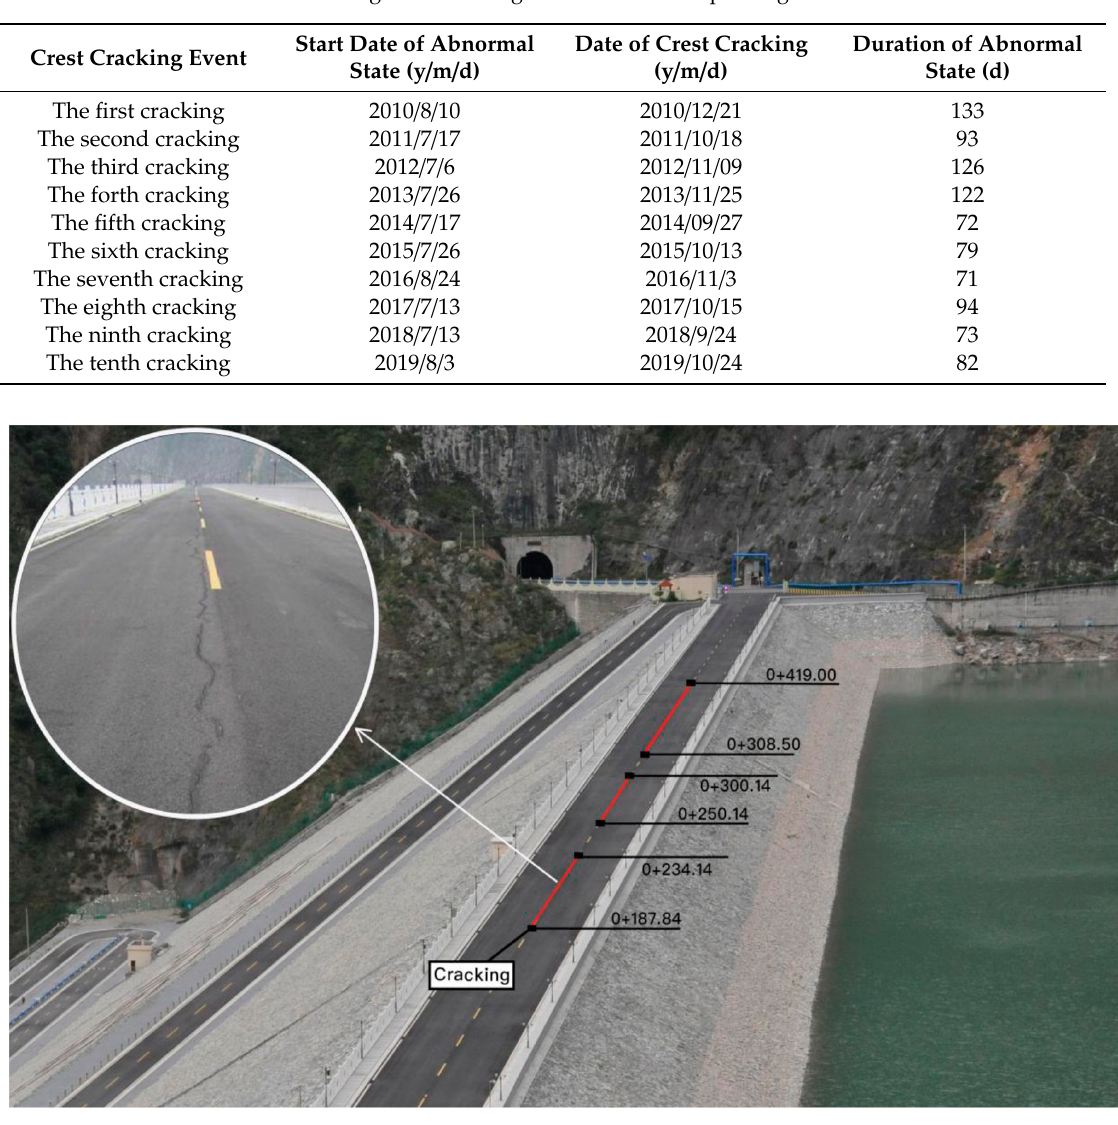
Figure 3. The distribution ranges and the photograph of the cracks.